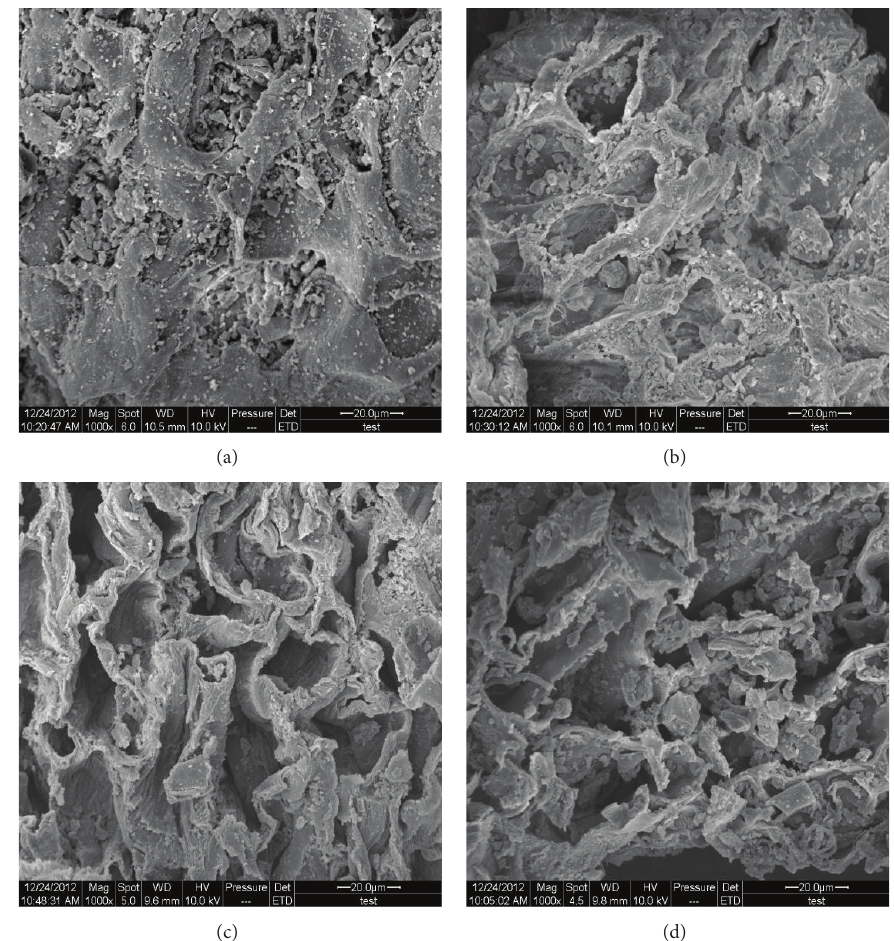
Figure 5: SEM images (20.0 lm, 15.0 kV) of untreated tree peony pod sample (a), sample after ME (b), sample after HRE (c), and sample after MAE